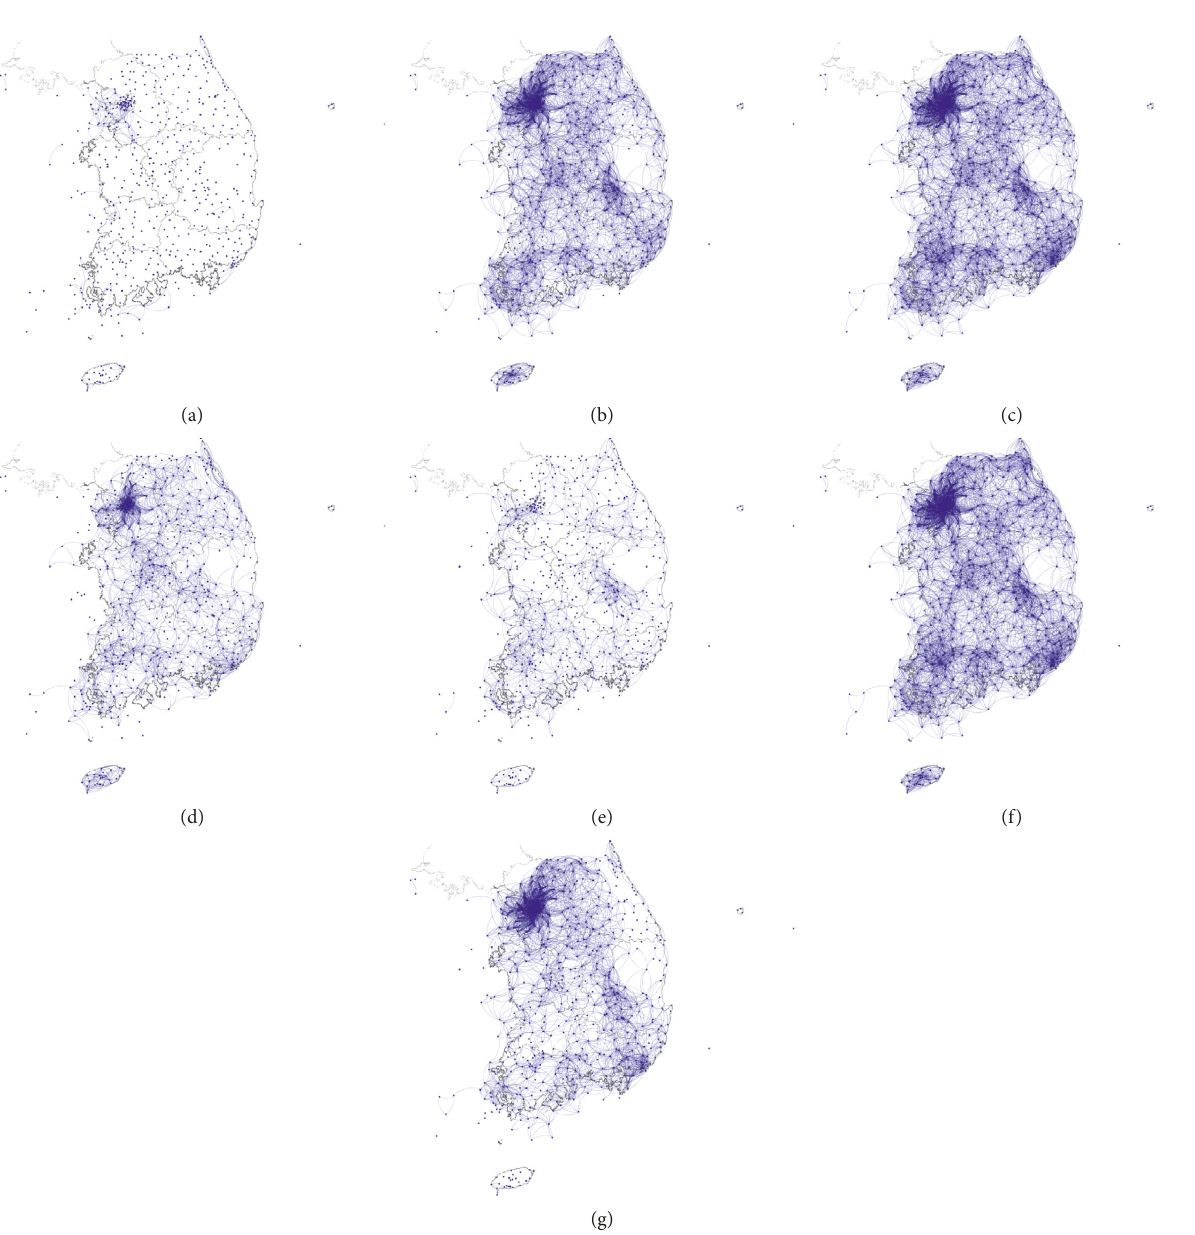
Figure 6: Similarity map for different meteorological elements. (a) Wind direction. (b) Wind speed. (c) Temperature. (d) Humidity. (e) Atmospheric pressure. (f) Precipitation. (g) Rainfall